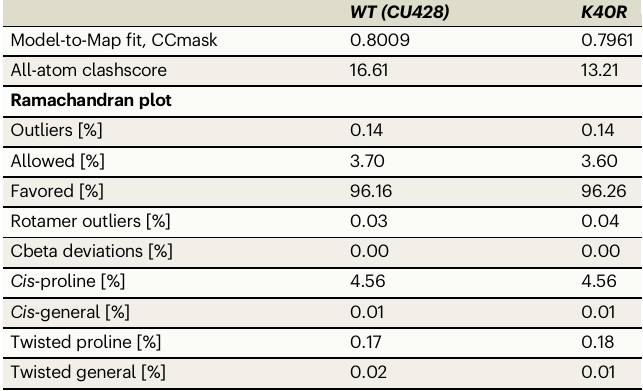
Table 2 | Re fi nement statistics of WT and K40R 48 nm models